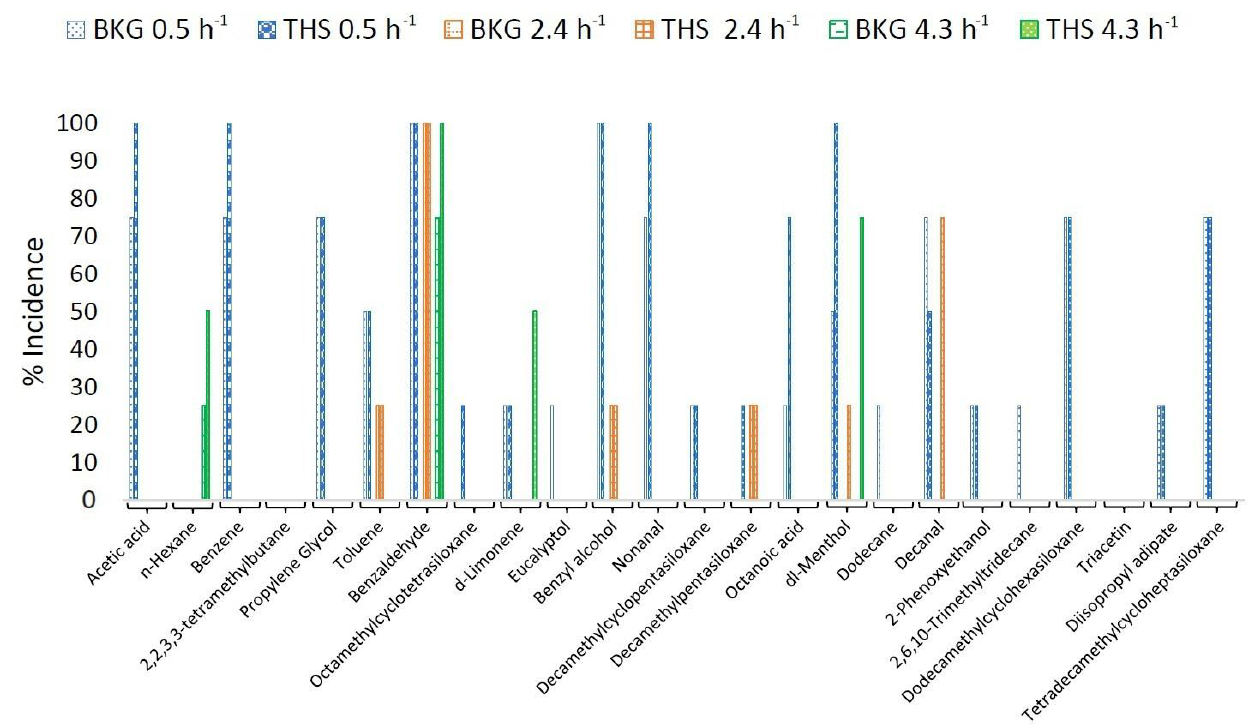
Figure 9. Comparison of the incidence of airborne compounds in the gas–vapor phase (C 6 –C 16 window in the TVOC method) under the Residential category III (0.5 h −1 ), Store (2.4 h −1 ), and Restaurant (4.3 h −1 ) environmental conditions.